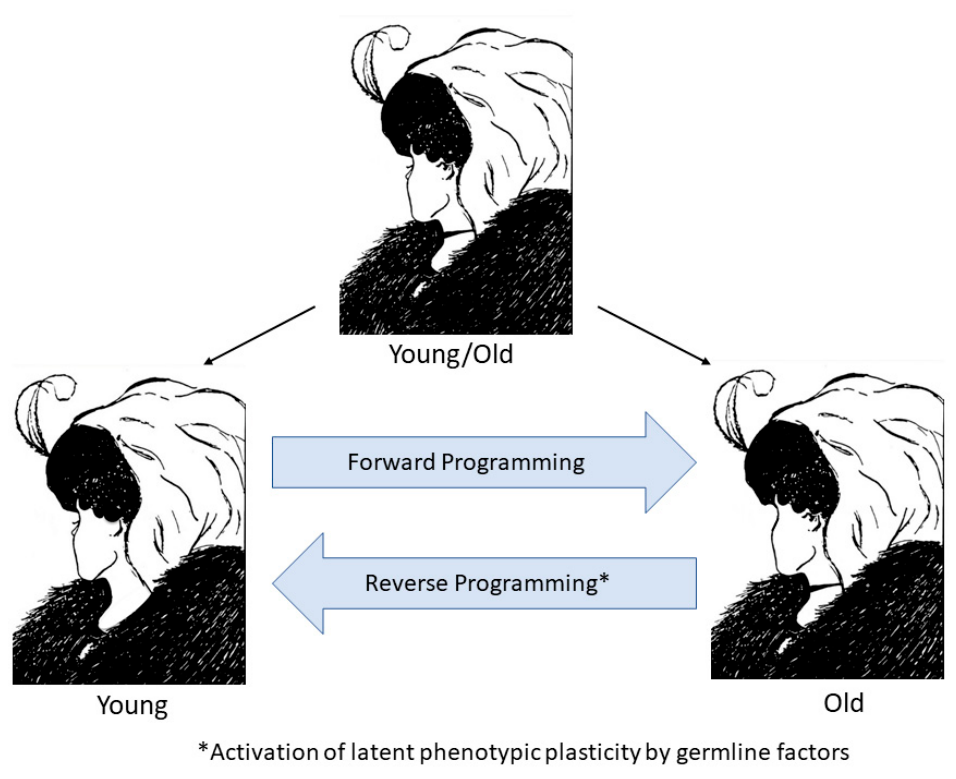
Figure 3. The two faces of epigenetic aging. The top illustration is an illusion designed so that the viewer will see either a young woman or an old woman. However, both are present in the same figure, just as the young and old woman are present in the same person as the genome’s epigenetic potential. Forward programming takes the young woman through a series of epigenetic states to an old woman as the DNAm, and other cellular clocks tick forward. Reverse programming can potentially be achieved using germline factors to revert the genome to an earlier epigenetic age.